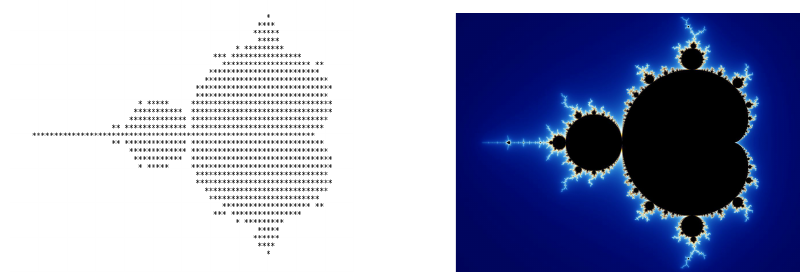
Figure 1. The Mandelbrot Set, first image (1978) (on left ) and the image created by Mandelbrot (on right ) at IBM